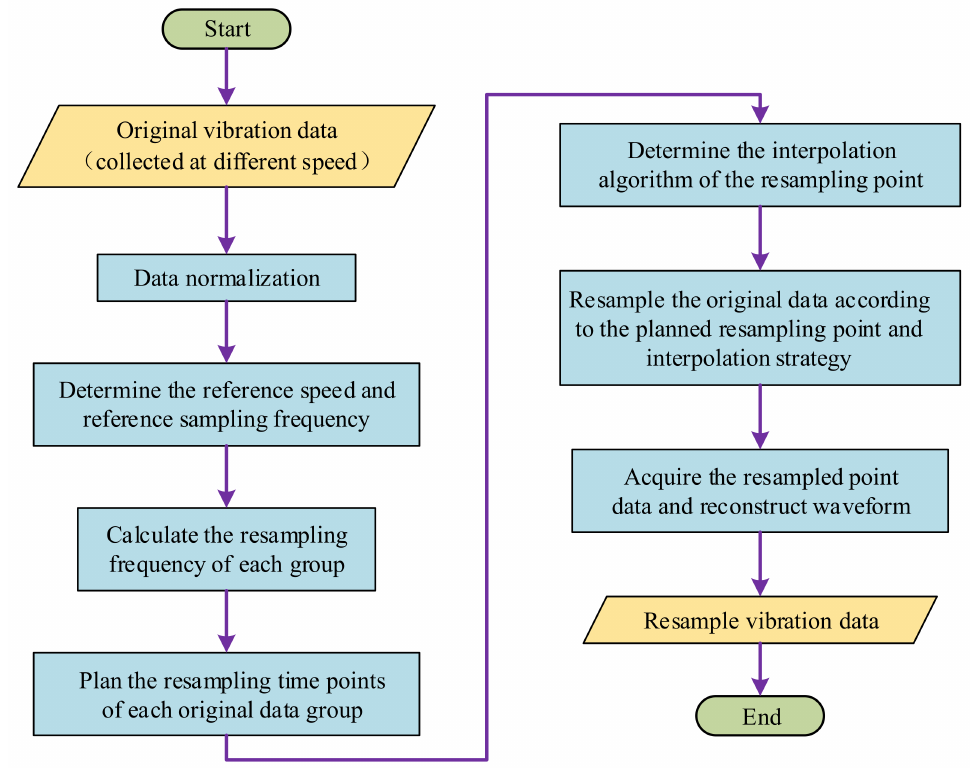
Figure 3. The implementation flow of the order tracking